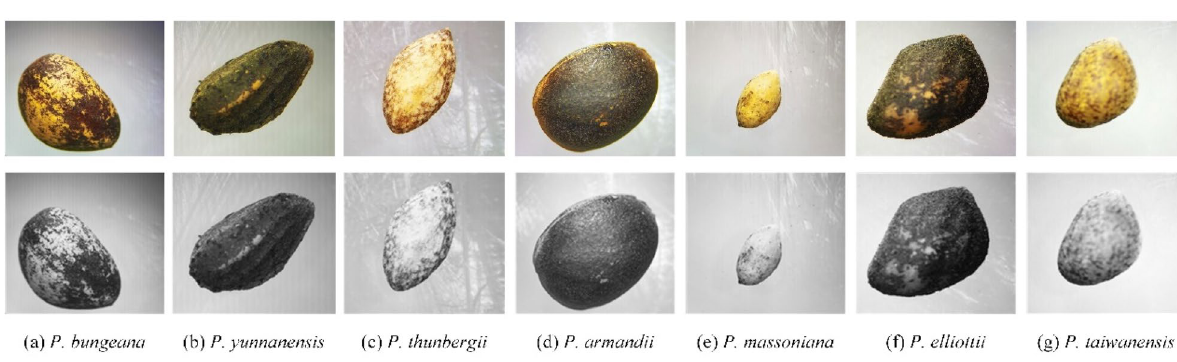
Figure 7. Results of image pre-processing for pine nuts of each species. Images have been clipped, flipped, resized and color transformed to